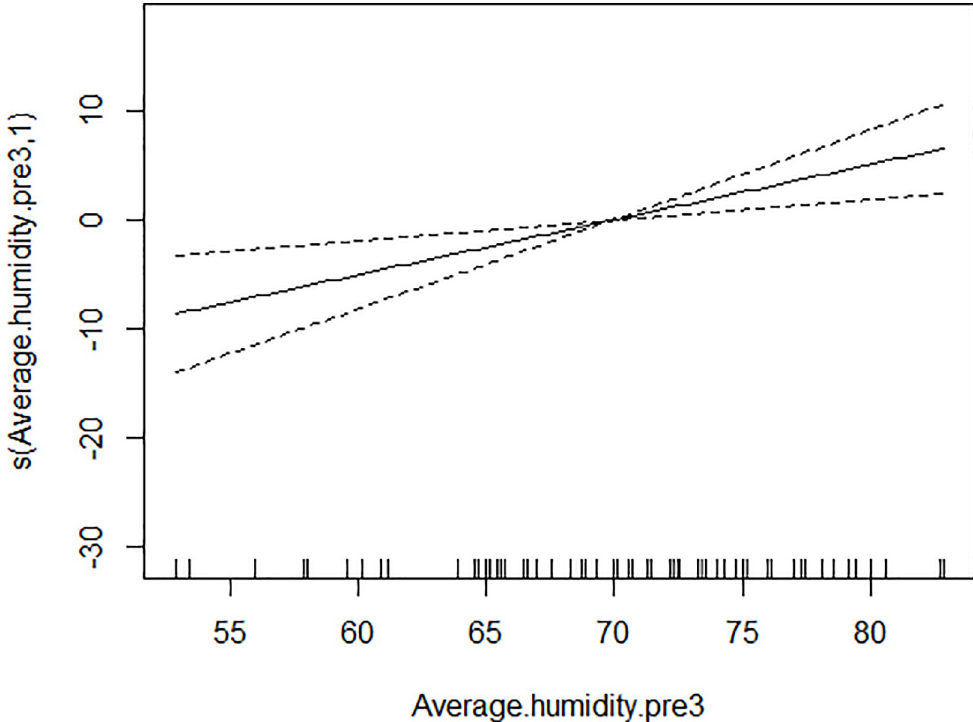
Fig 5. The relationship between CI and average humidity pre 3 weeks.